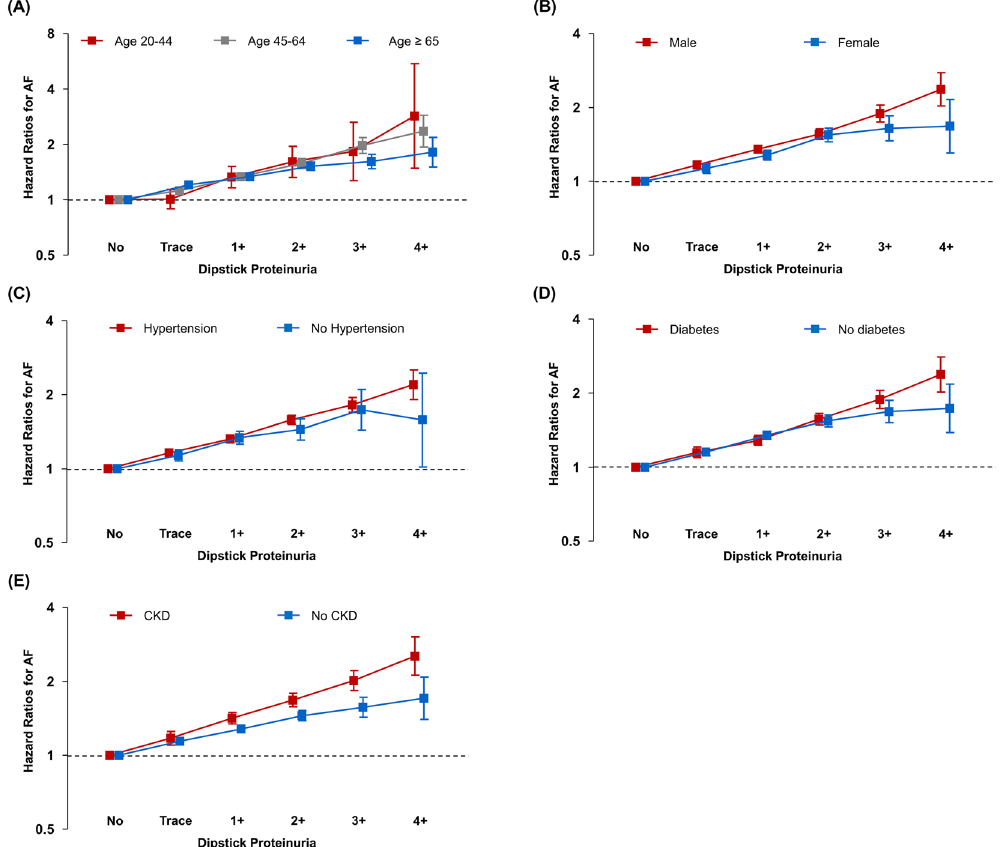
Figure 2. Subgroup analysis. Graded risk of atrial fibrillation development according to the severity of dipstick proteinuria was consistent regardless of ( A ) age, ( B ) sex, ( C ) hypertension, ( D ) diabetes mellitus, and ( E ) chronic kidney disease. Hazard ratios were calculated using a Cox proportional model adjusted for age, sex, body mass index, smoking, alcohol consumption, exercise frequency, diabetes, hypertension, dyslipidemia, ischemic heart disease, congestive heart failure, stroke, and chronic obstructive pulmonary disease, except for the stratification variable. AF, atrial fibrillation; CKD, chronic kidney disease